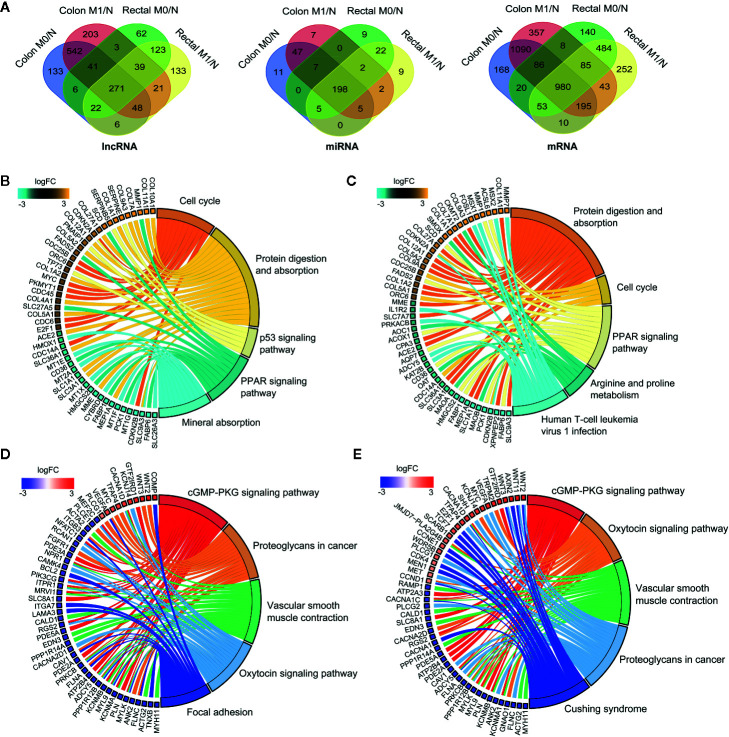
Global landscape of differentially expressed RNAs in colon and rectal cancers. (A) Venn diagrams showing the overlapping differentially expressed lncRNAs (left), miRNAs (middle) and mRNAs (right) among colon M0/N, colon M1/N, rectal M0/N and rectal M1/N groups. (B-E) The top five significantly enriched KEGG pathways and related genes in colon M0/N (B), colon M1/N (C), rectal M0/N (D) and rectal M1/N (E) groups, respectively. M0 represents patients without distant metastasis; M1 represents patients with distant metastasis; N represents normal paracancerous tissue.